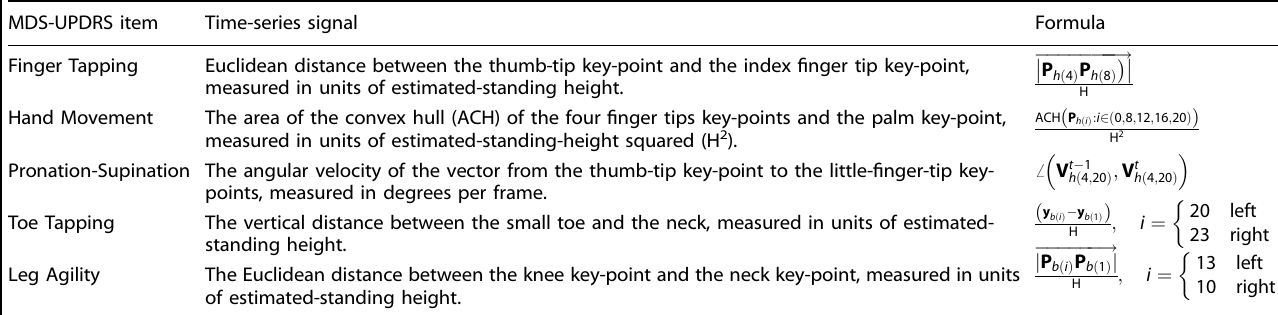
Table 7. Chosen fi nd_peaks parameter set for each bradykinesia item.